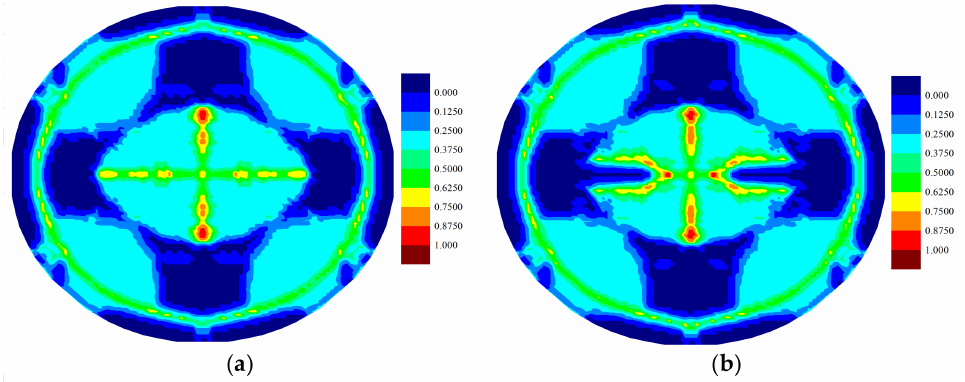
Figure 13. Matrix damage comparison of middle (7th) ply for ( a ) coupled case and ( b ) uncoupled case at 0.28453 × 10 − 3 s.